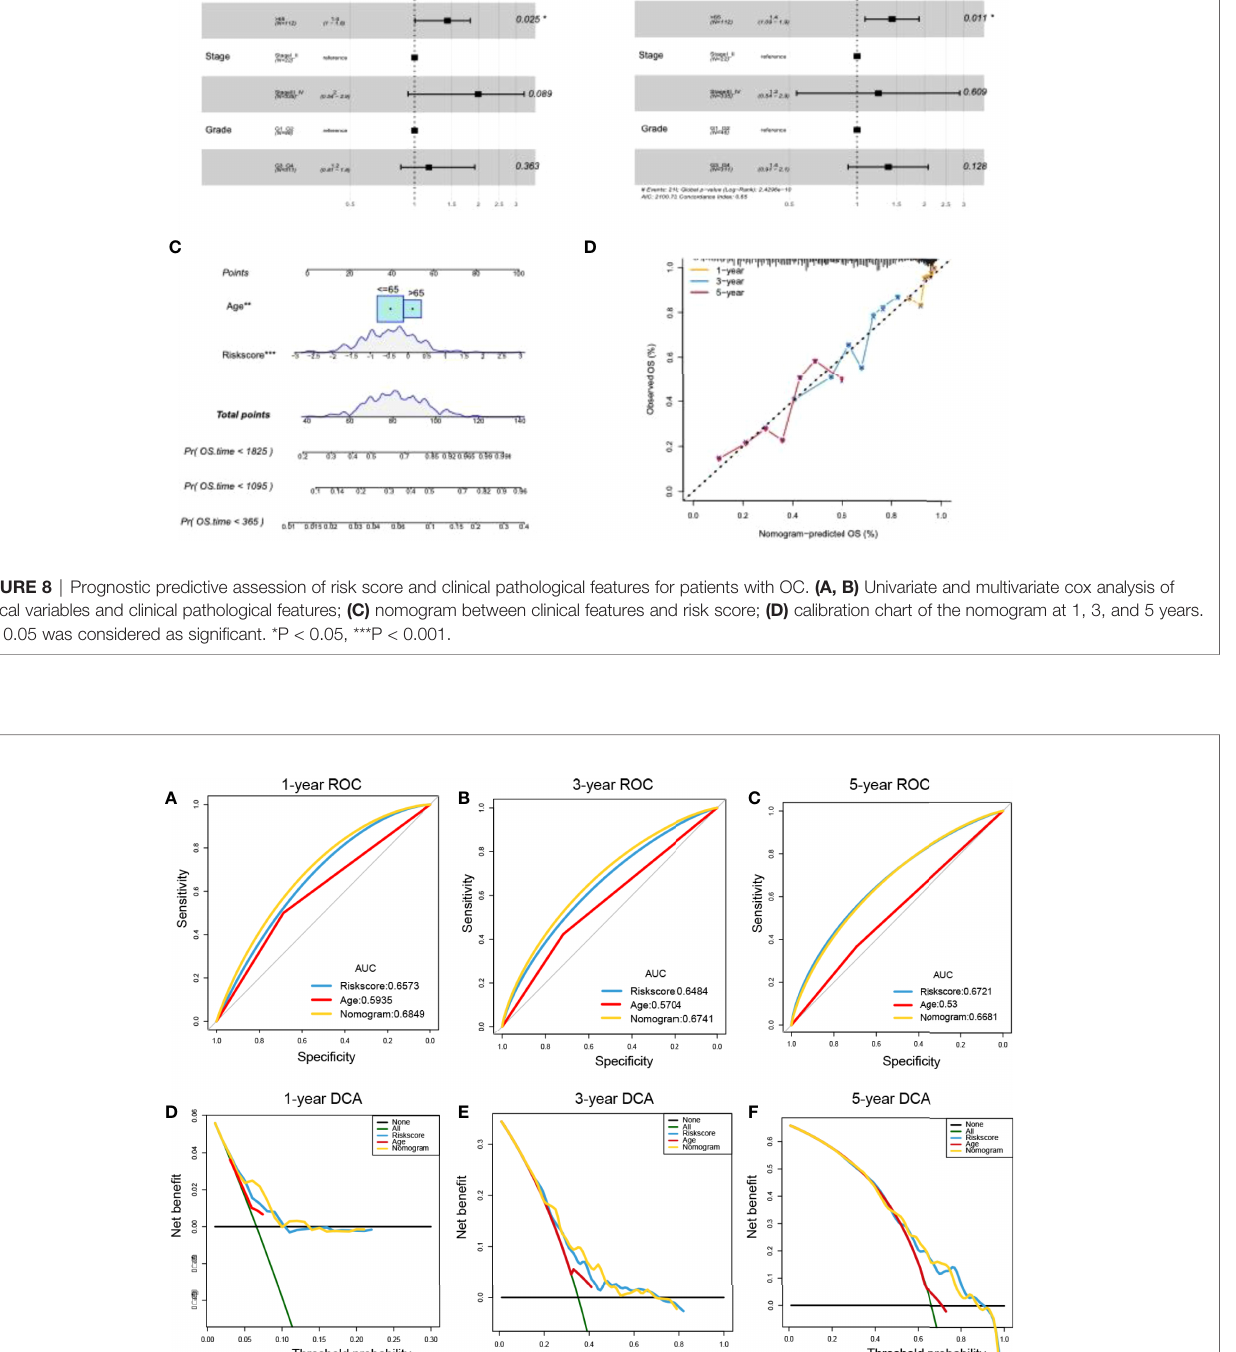
FIGURE 9 | Prognostic performance assessment of risk score. (A – C) ROC curves of risk score nomograms at 1, 3, and 5 years, respectively; (D – F) DCA distribution maps at 1, 3, and 5 years,